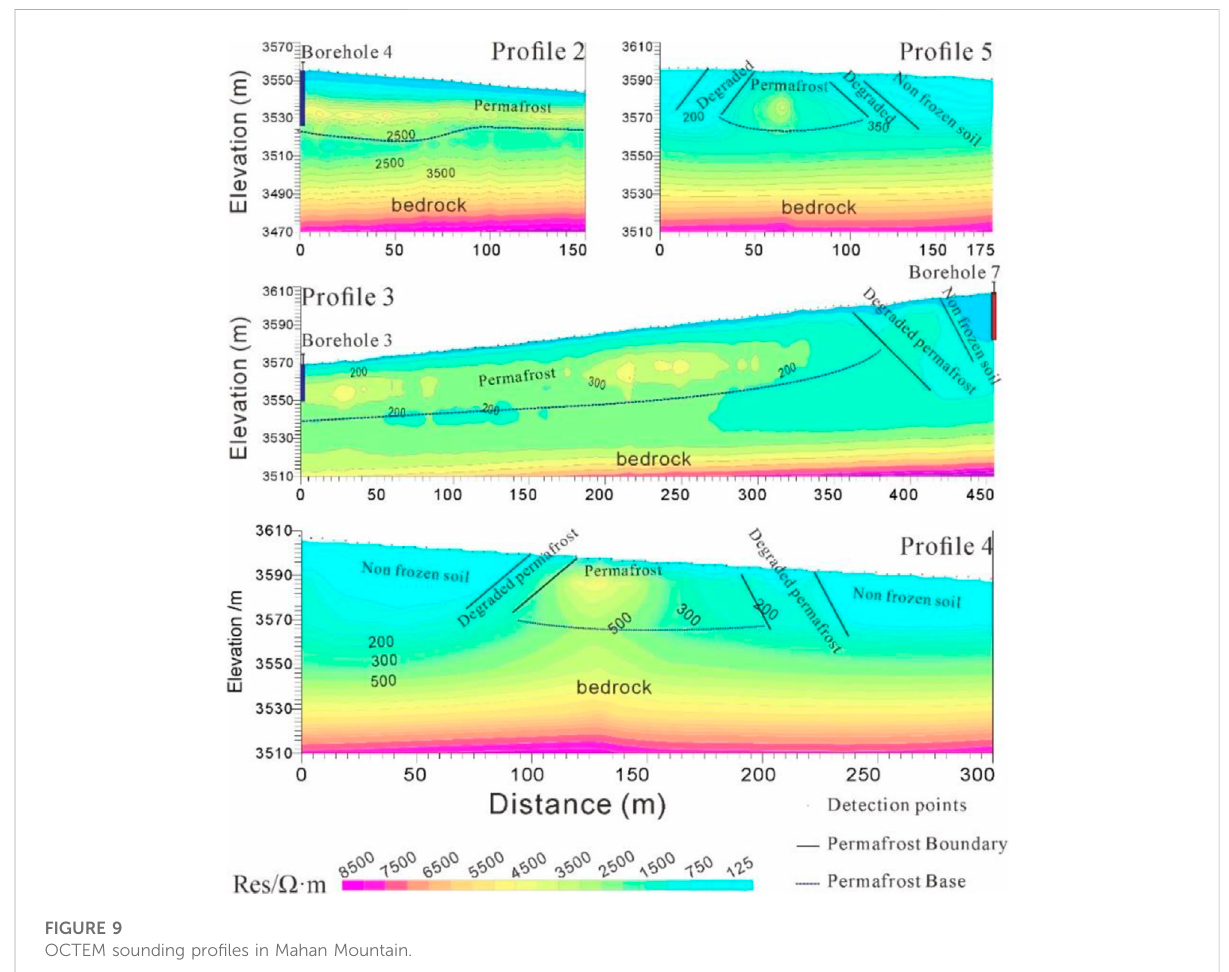
FIGURE 9 OCTEM sounding pro fi les in Mahan